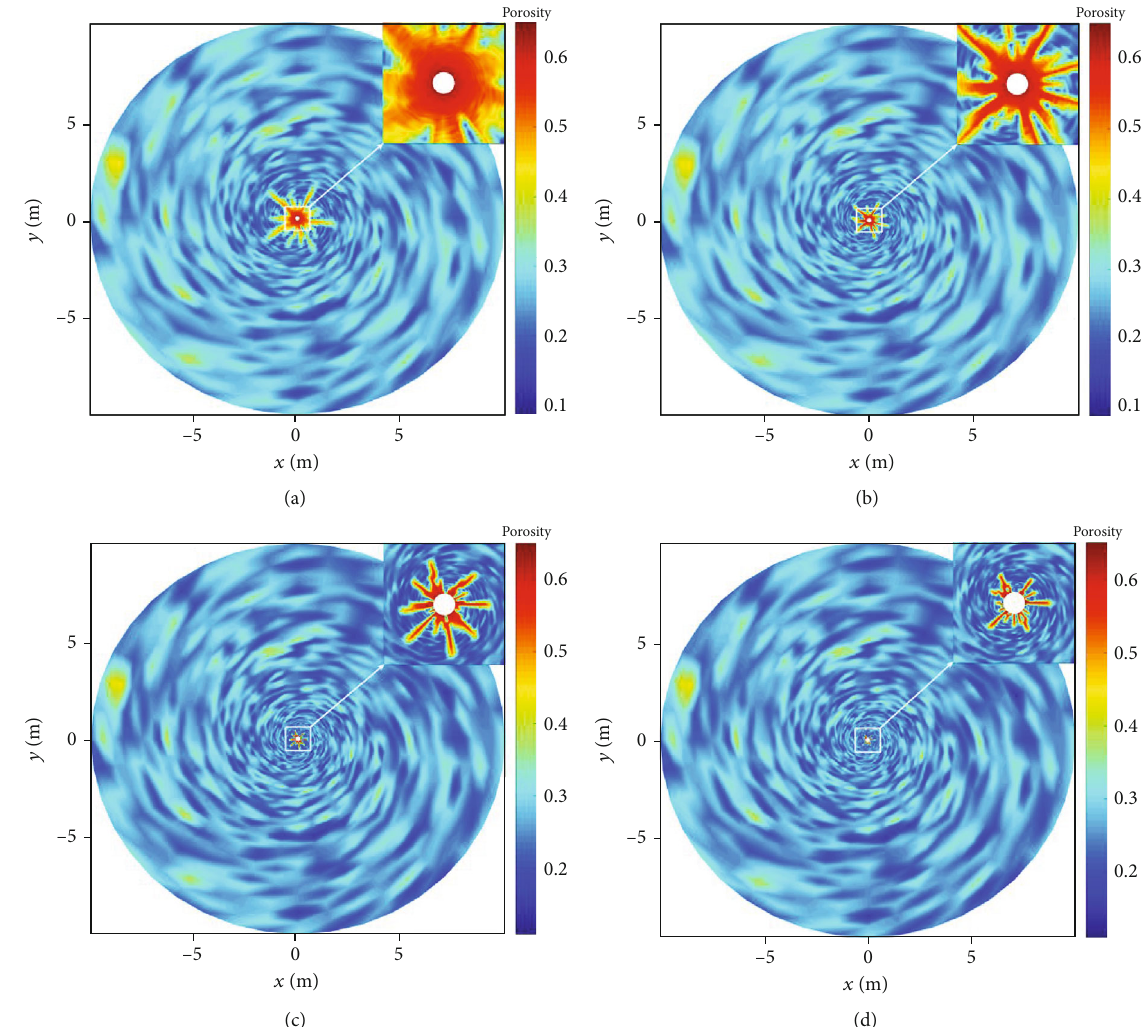
Figure 7: Porosity distribution near the injection well under di ff erent values of critical fl uid velocity. (a) 0 : 3 × 10 − 3 m/s . (b) 0 : 5 × 10 − 3 m/s . (c) 1 : 0 × 10 − 3 m/s . (d) 1 : 5 × 10 − 3 m/s